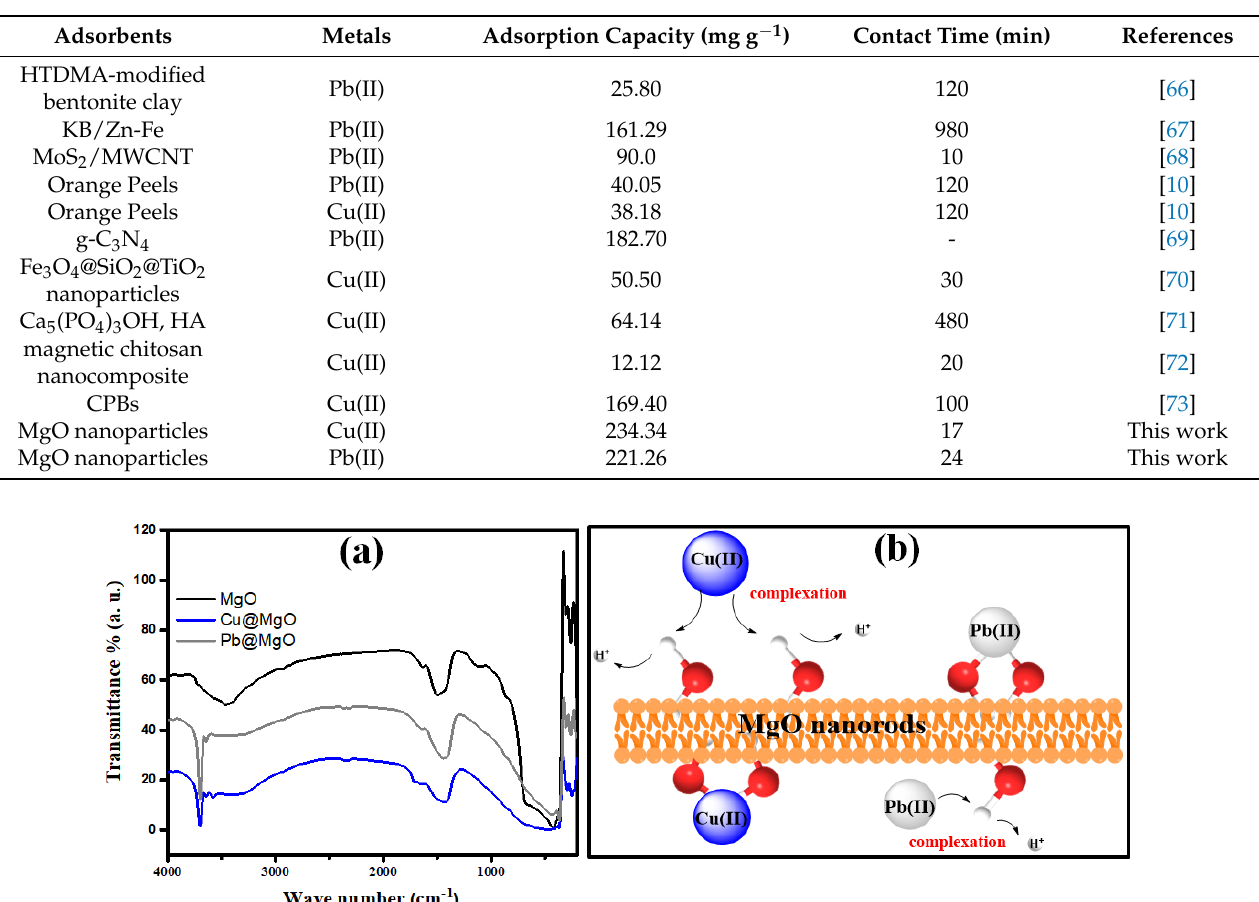
Table 3. Adsorption capability of divers sorbents for the Pb(II) and Cu(II) elimination.